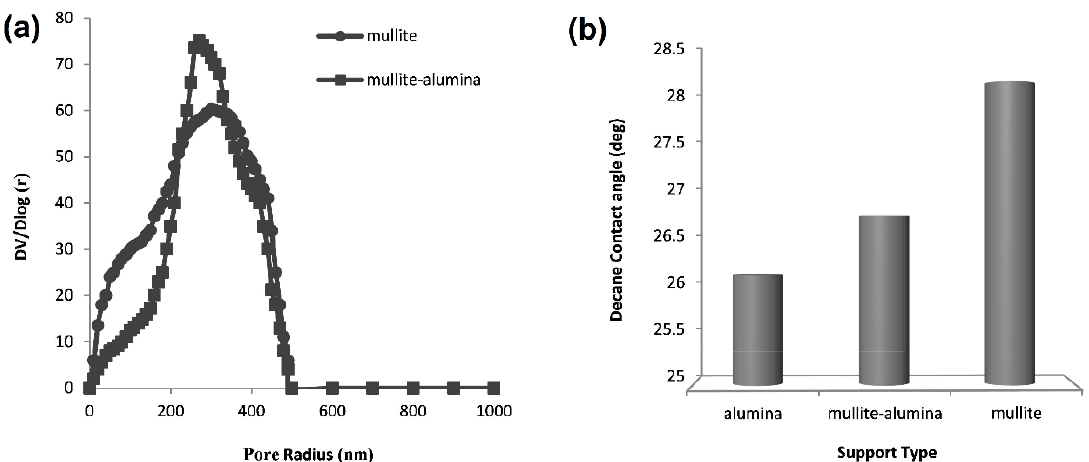
Figure 2. ( a ) The Mercury Porosimetry analysis of supports; ( b ) The decane drop contact angle with different ceramic supports.